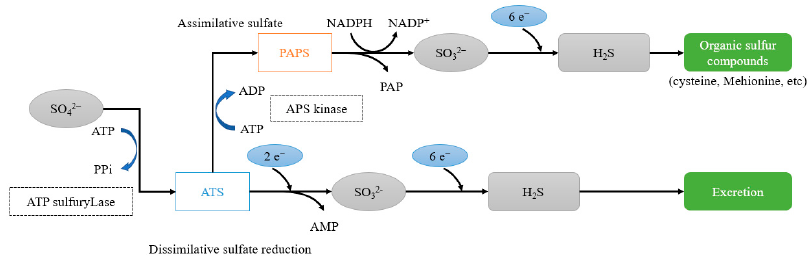
Figure 1. Metabolic reaction process of sulfate reducing bacteria.